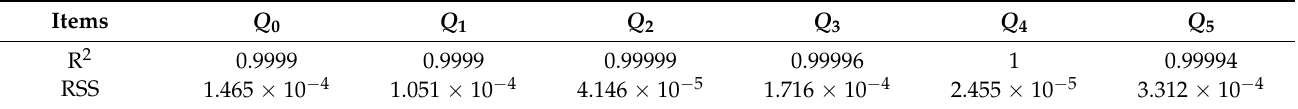
Table 2. Curve fitting results.